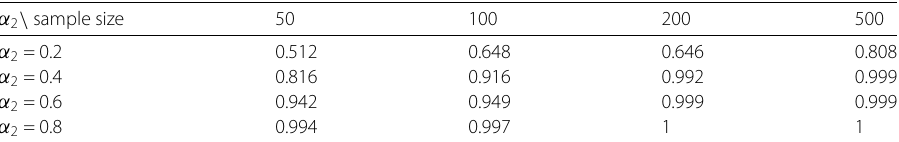
Table 9 Empirical powers for Model IV with λ = 2 α 2 \ sample size 50 100 200 500 α 2 = 0.2